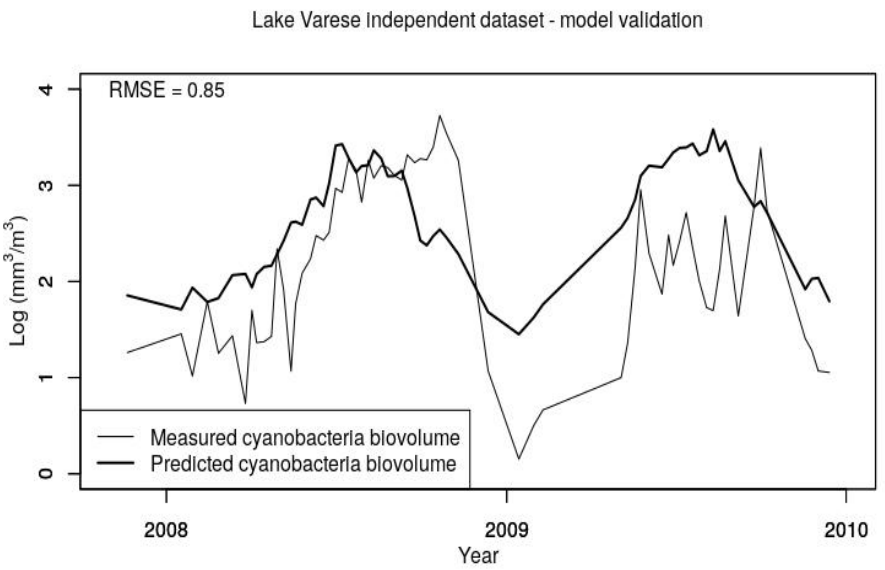
Figure 6. Validation of the model: Measured and predicted cyanobacteria biovolumes at Lake Varese using an independent dataset (not included in the MLR analysis) of water samples collected at Lake Varese during the period 2008–2010 by JRC. RMSE indicates the root mean square error of predicted vs. measured values.